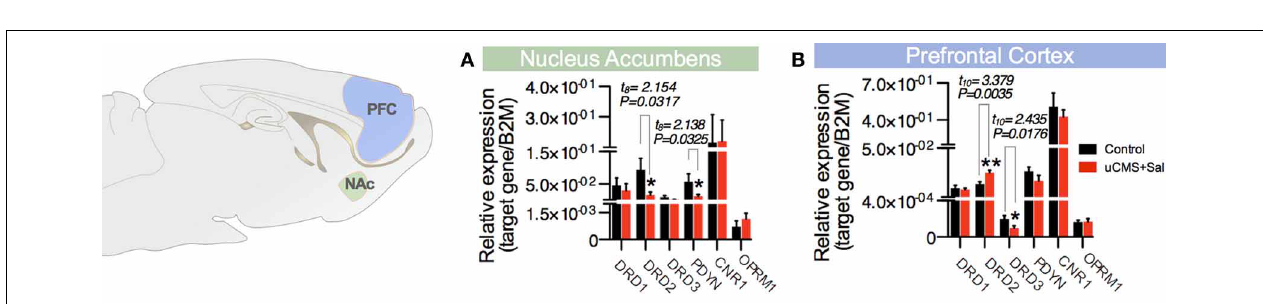
hyperanxious behavior of uCMS-exposed animals; the similar exploratory behavior of control and uCMS animals supports the SDT arena as a non-aversive test environment. (D–F) Evaluation in the open-field test, further indicates that anxious-like behavior (D) did not affect total exploratory activity (E,F) . ∗ P < 0 . 05 Error bars, s.e.m., n = 7–9.